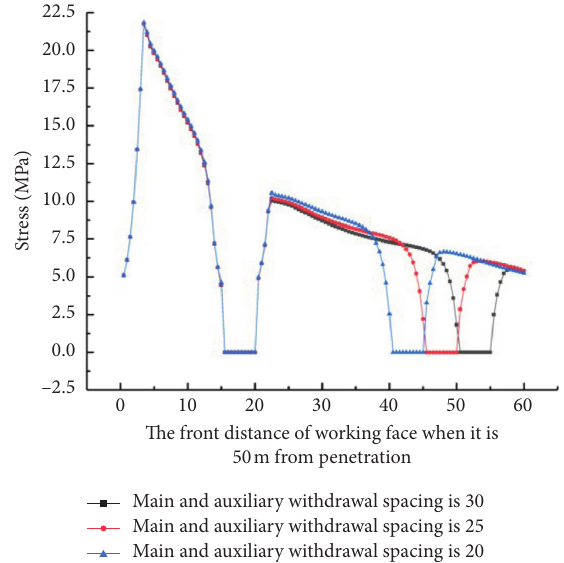
Figure 14: Vertical stress curve when Panel 31113 is 15m from